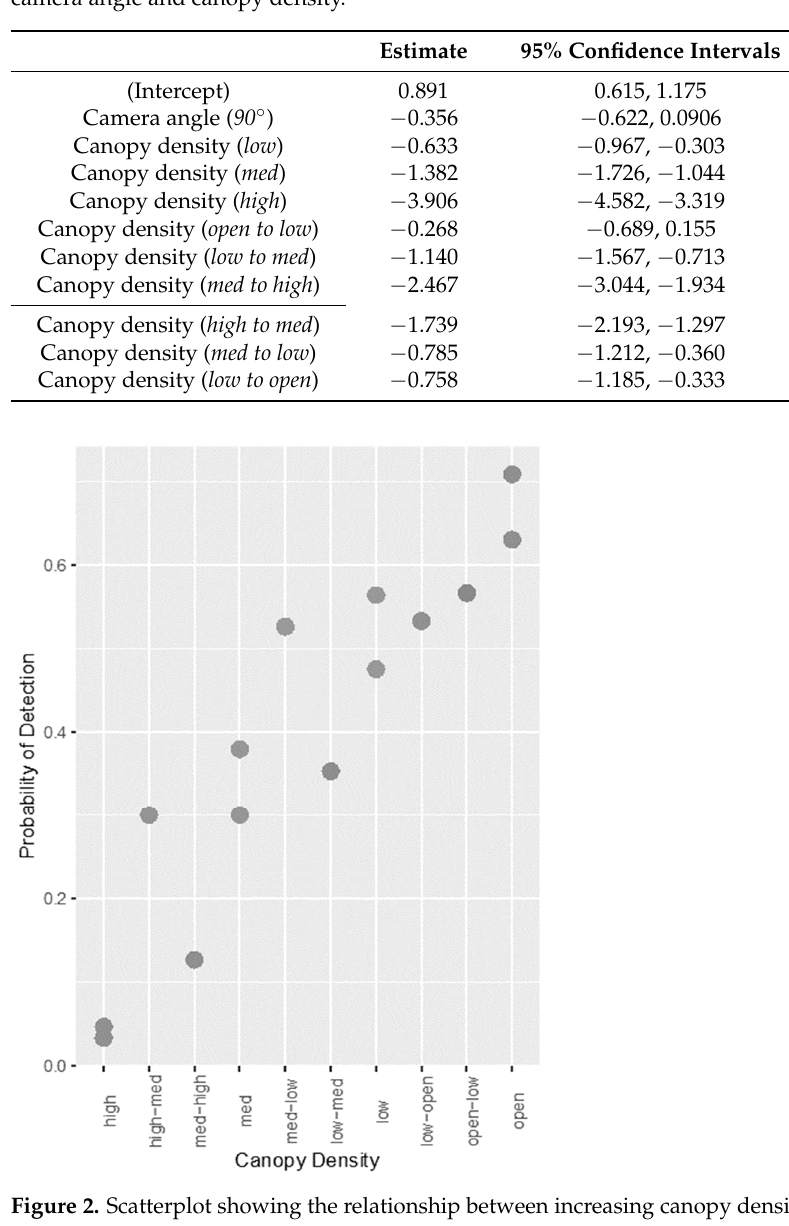
Table 3. The model with the best fit for RGB images with manual detection includes the variables camera angle and canopy density.